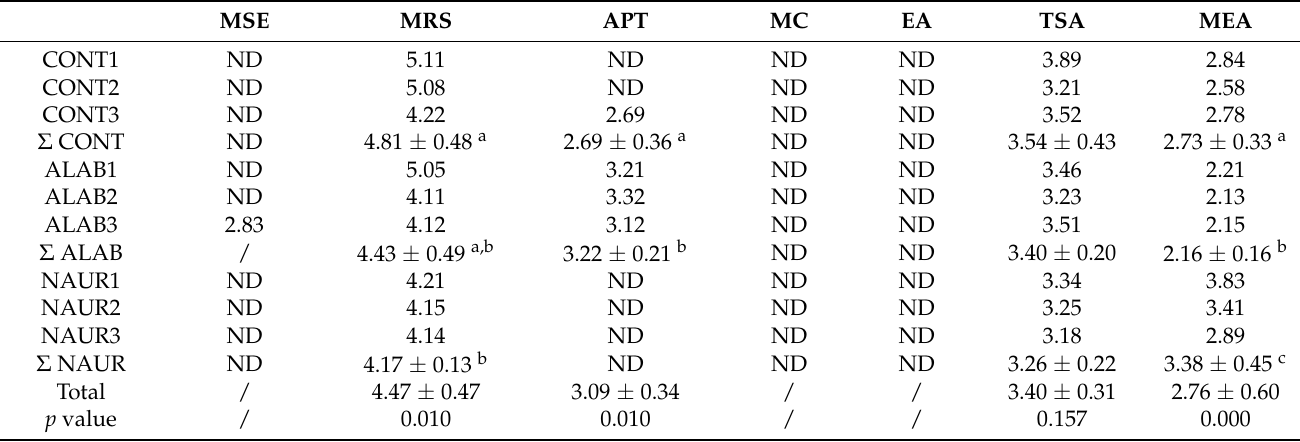
Table 2. Number of isolated groups of microorganisms in log